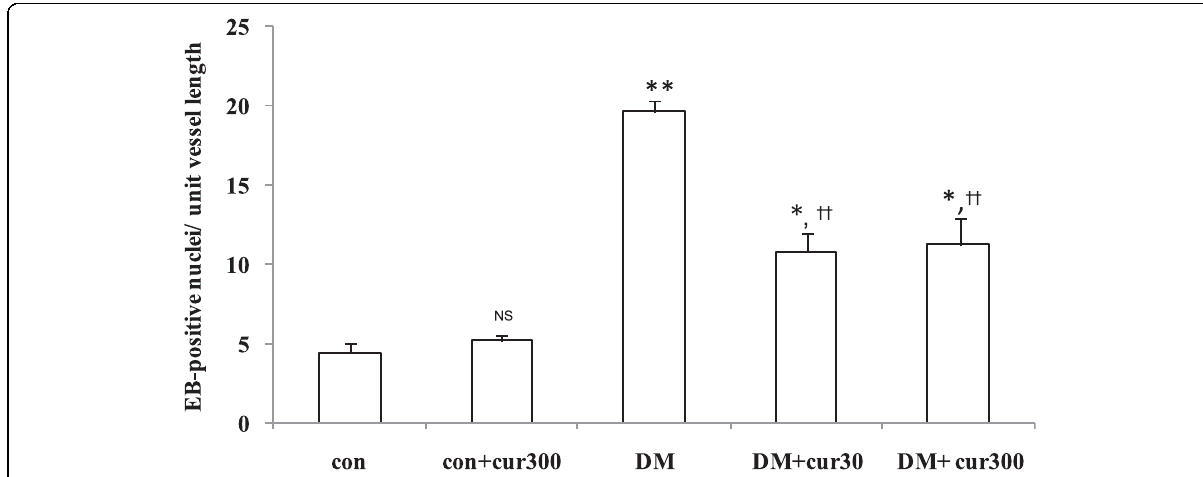
Figure 4 Number of ethidium bromide-positive nuclei . Histogram showing the ethidium bromide-positive nuclei along the mesenteric arterioles of rats that were untreated diabetics (DM), diabetics treated with low curcumin (DM+cur30), diabetics treated with high curcumin (DM +cur300), controls (con) or controls treated with curcumin (con+cur300) rats. Data are expressed as mean ± SEM (n = 5 for each group). NS, no significant difference compared to control arterioles; ** P < 0.01 and * P < 0.05, significant difference compared to control arterioles; †† P < 0.01, significant difference compared to diabetic